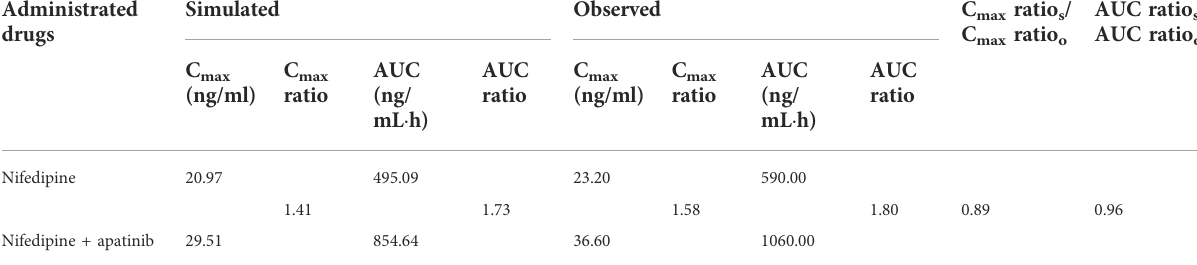
TABLE 4 Comparison of model-predicted AUC, and C max to the observed one in the presence to the absence of apatinib. Administrated drugs